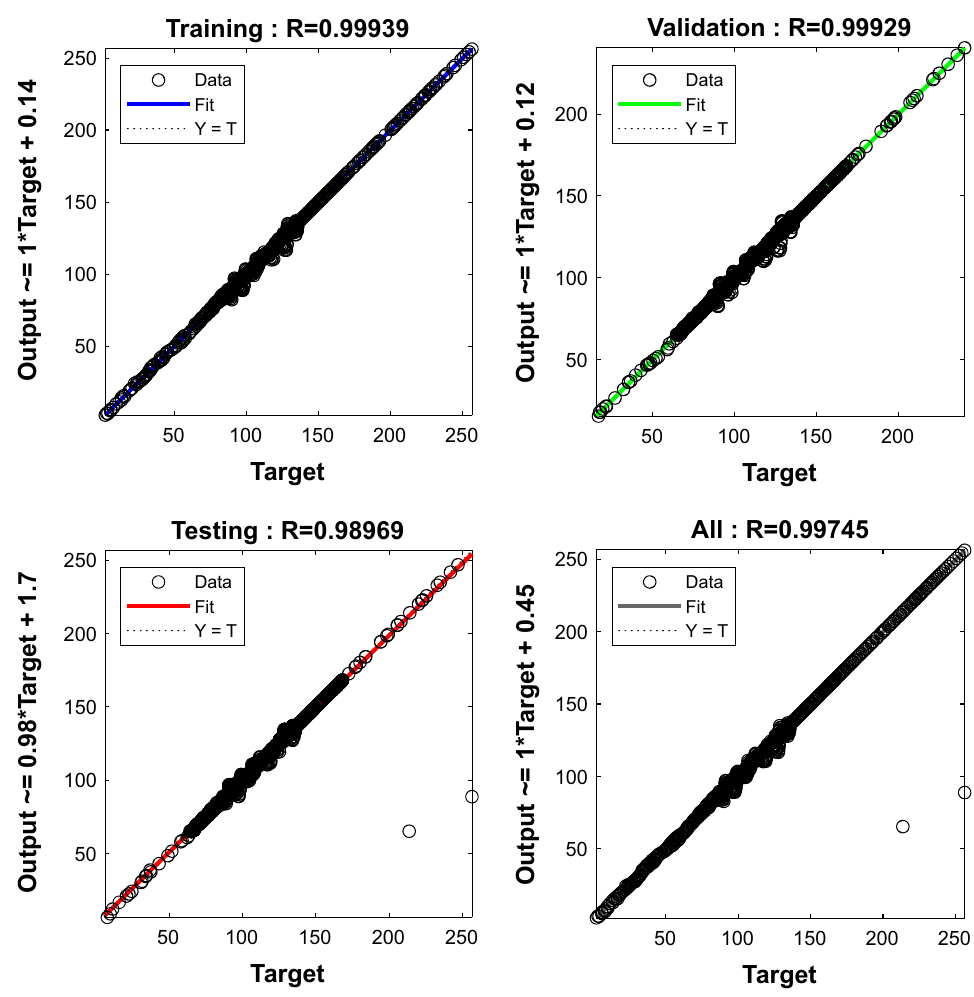
Figure 9. Regression plots during ANN training for gas + CO 2